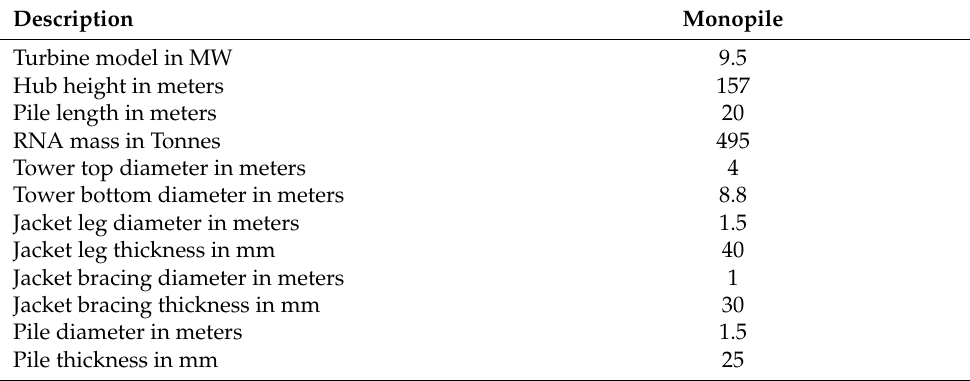
Table 5. Input data of the structures and the jacket foundation.